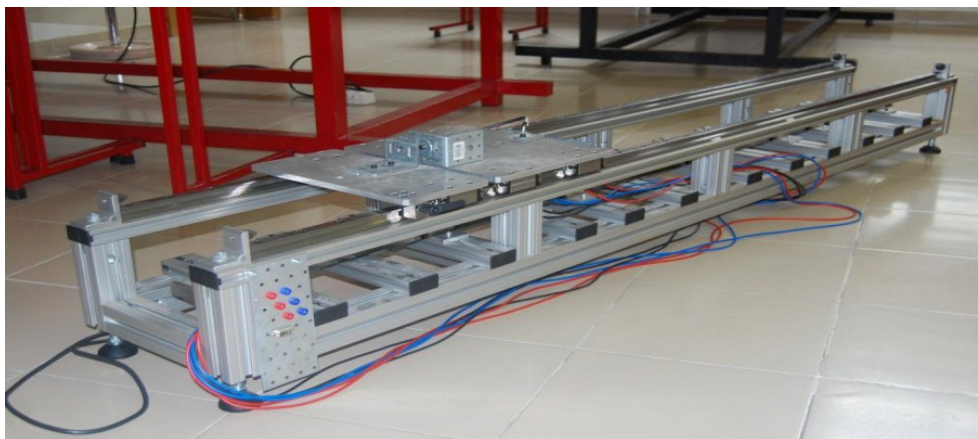
Figure 1. Overview of a LSRA for high precision positioning applications.